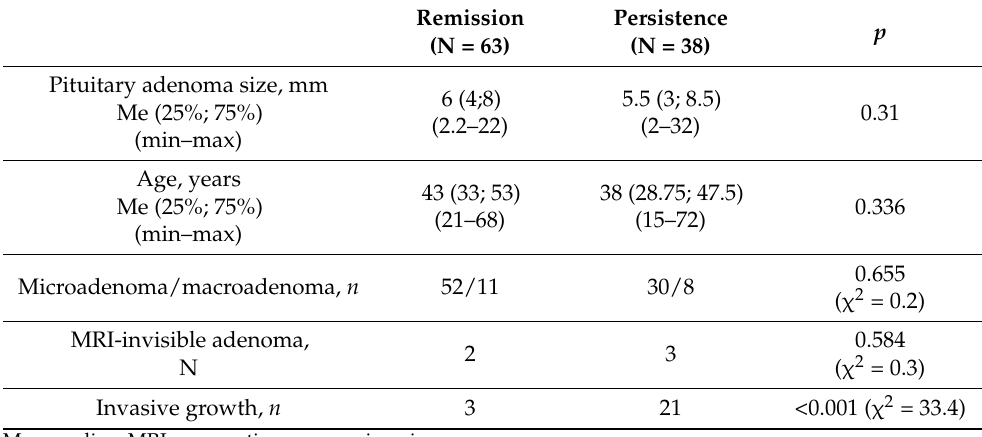
Table 2. Preoperative MRI data in patients with remission and persistence of CD one year after